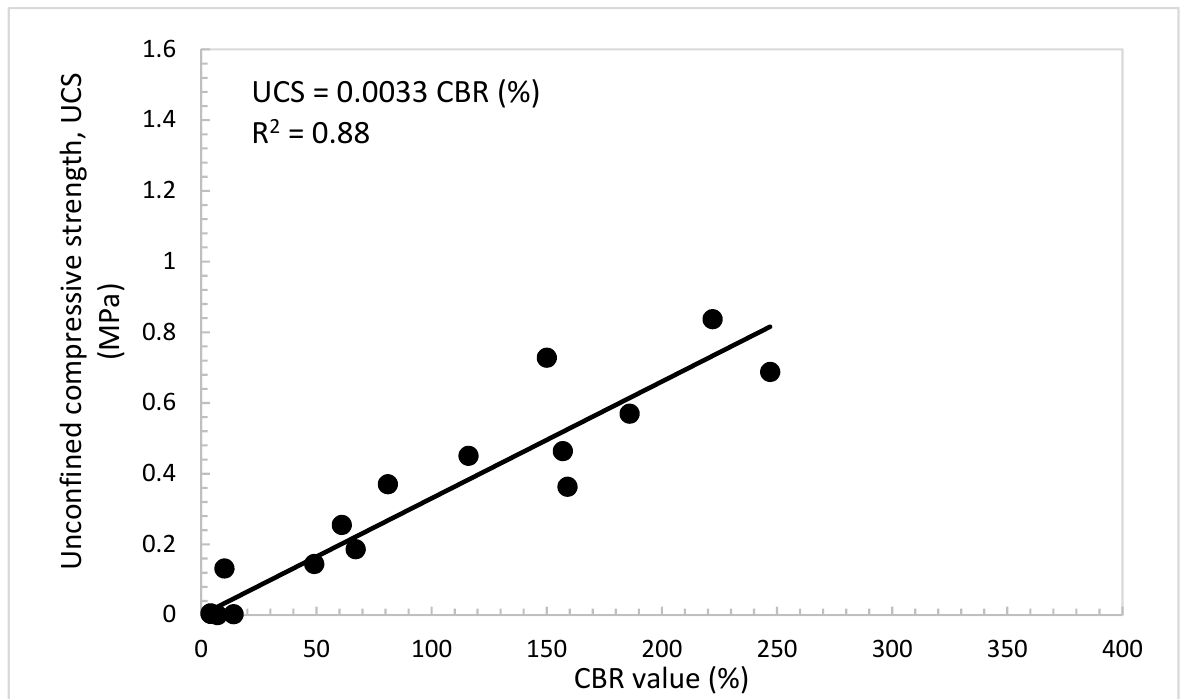
Figure 15. Unconfined compressive strength, UCS vs. CBR value of the treated dune sand.